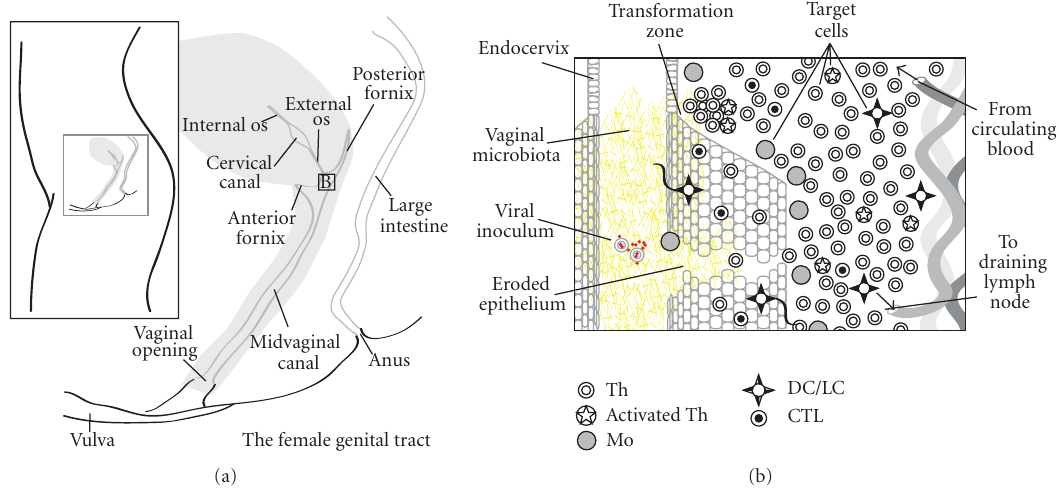
Figure 1: Mechanisms of vaginal HIV transmission. (a) Overview of the major anatomical features of the female genital tract (FGT). (b) Overview of hypothetical mechanisms of HIV transmission in the female genital tract. See text for